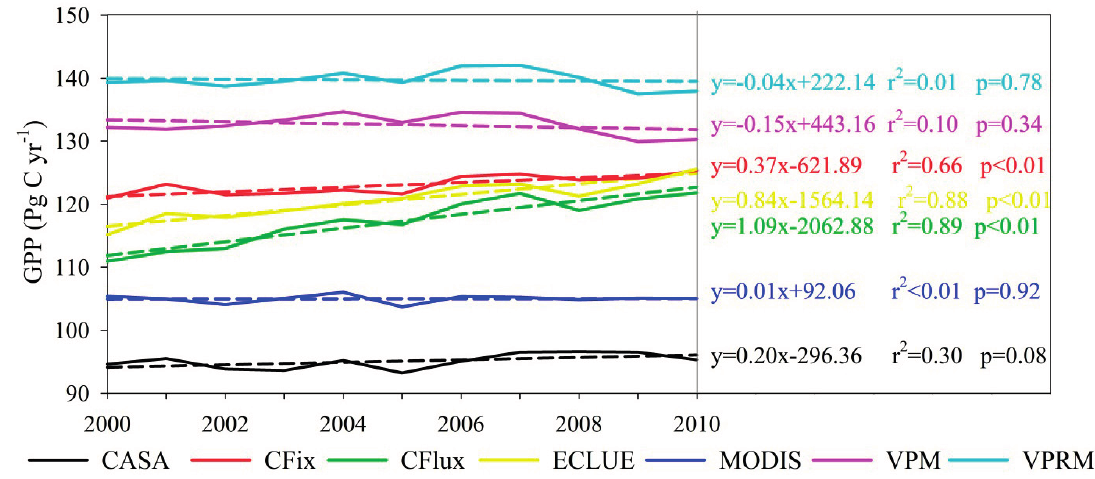
Figure 3. Interannual variability of the GPP estimates of the seven light use efficiency (LUE) models from 2000 to 2010.